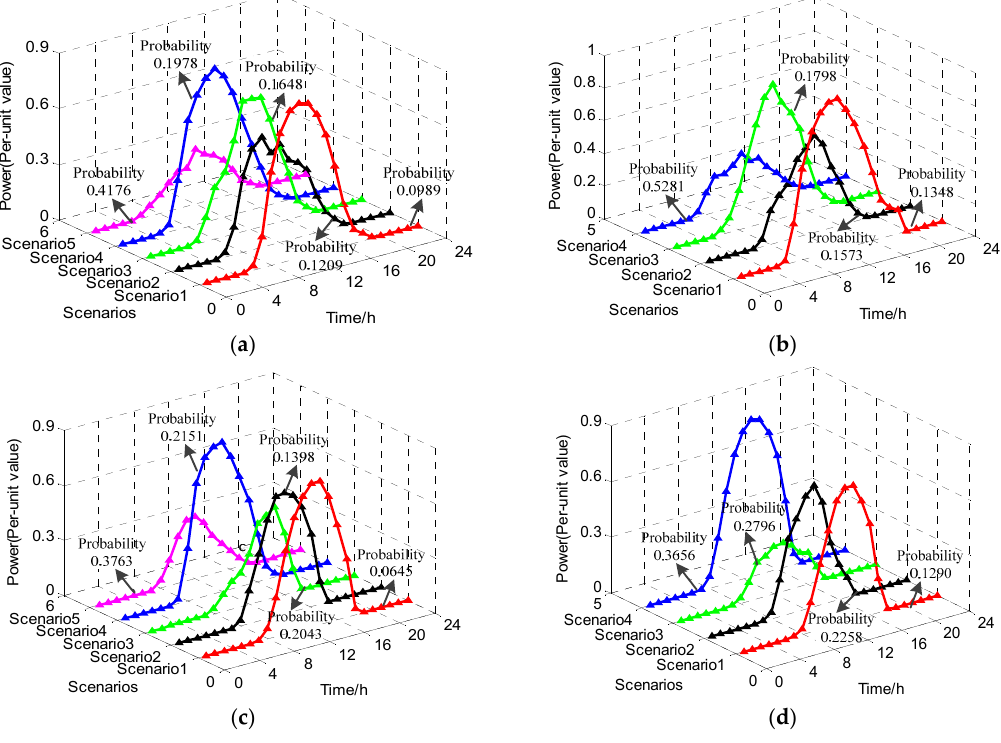
Figure 9. The scenario of photovoltaic power output for the four seasons: ( a ) The spring scenario of photovoltaic power output; ( b ) The summer scenario of photovoltaic power output; ( c ) The autumn scenario of photovoltaic power output; ( d ) The winter scenario of photovoltaic power output.